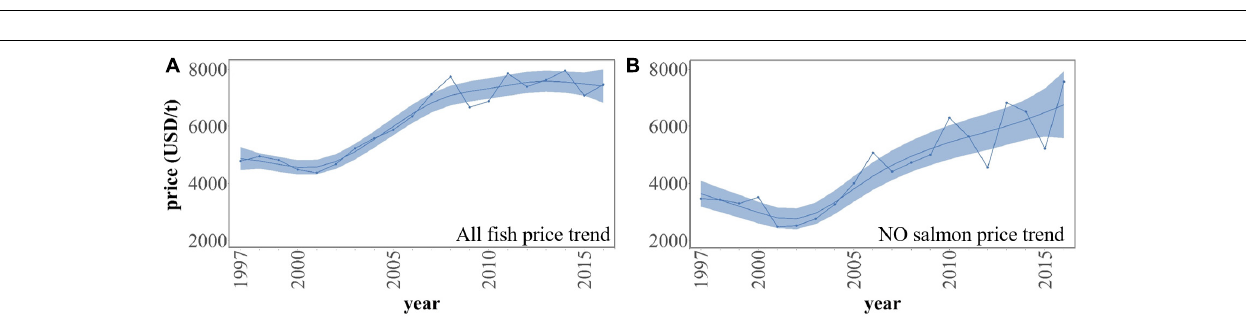
FIGURE 5 | Historical fish feed ingredient price trends for grains, wheat, and oilseed (A) , fishmeal, fish oil, vegetable oil (B) for the respective available historical data coverage (line with dots) in USD/unit with the generalized additive model (GAM) fit (solid line) and the 95% confidence interval corresponding to the predicted standard error of the model fit (shade). Data sources: crop prices: FAO Food Price Monitoring and Analysis Tool, World Bank Commodity Price Data and EC Commodity Price Dashboard, fishmeal: Indexmundi database, fish oil: commodity statistics report (Globefish, 2019).